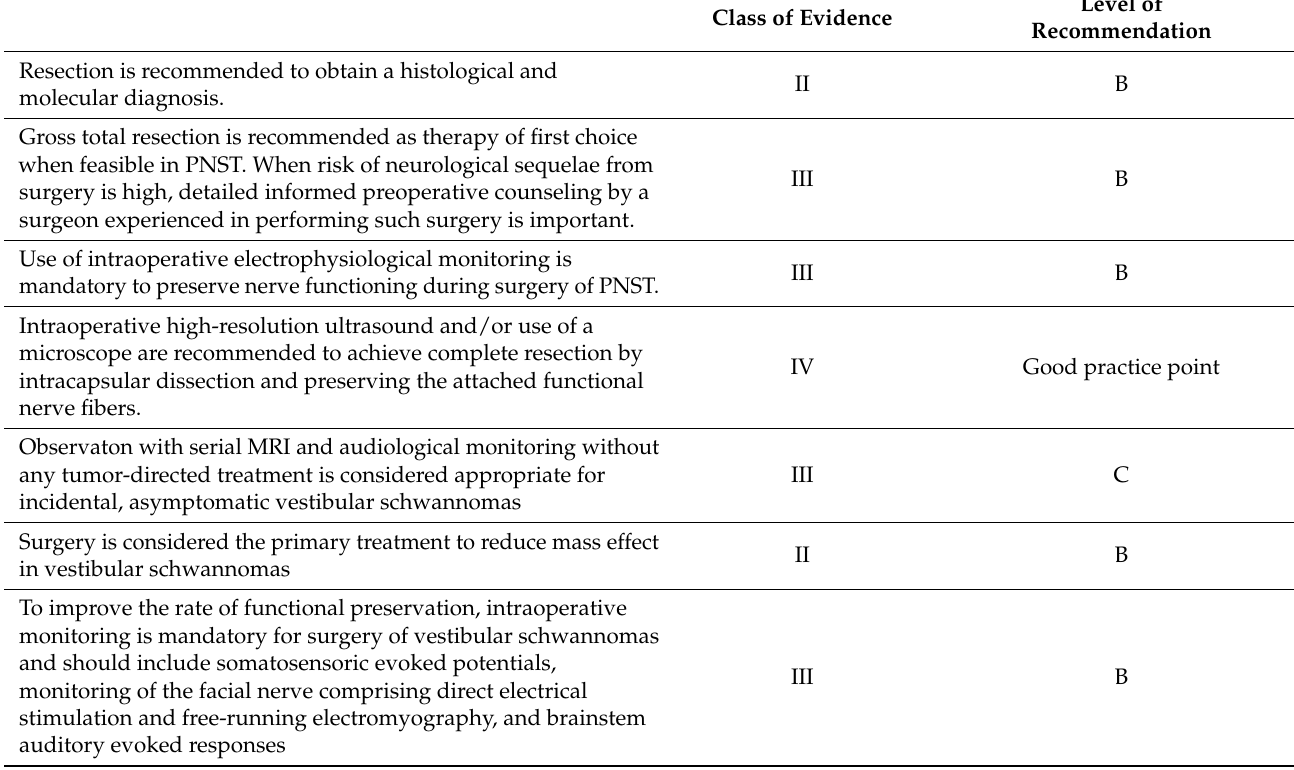
Table 4. General treatment